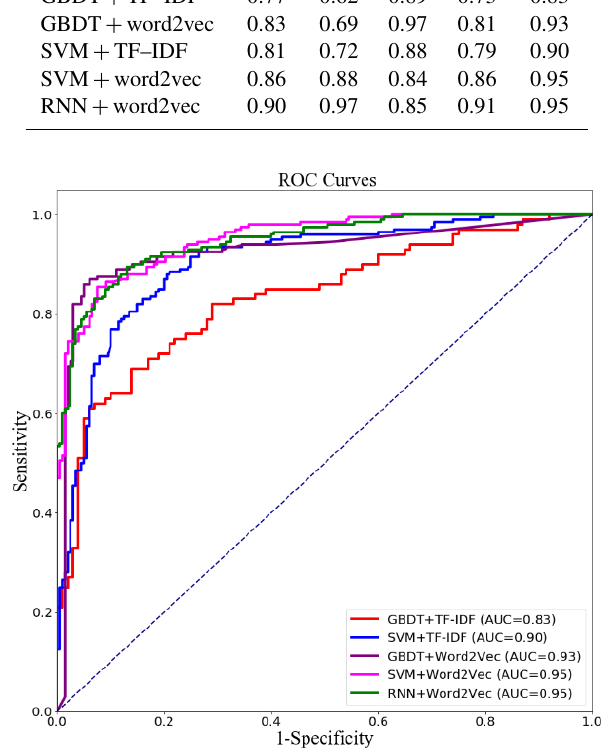
Figure 6. ROC curves of the three